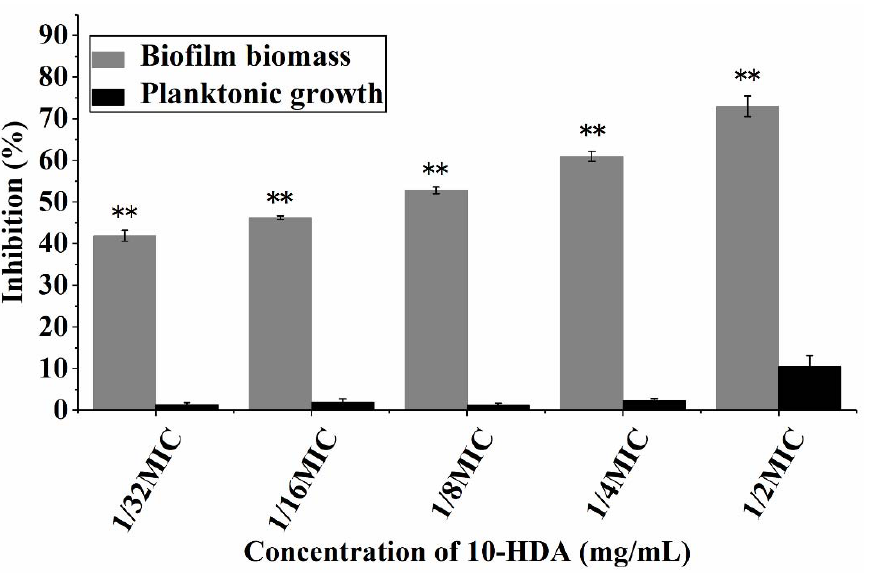
Figure 1. Effect of 10-HDA at sub-MIC levels on the planktonic growth and biofilm biomass of S. aureus . ** p < 0.01.